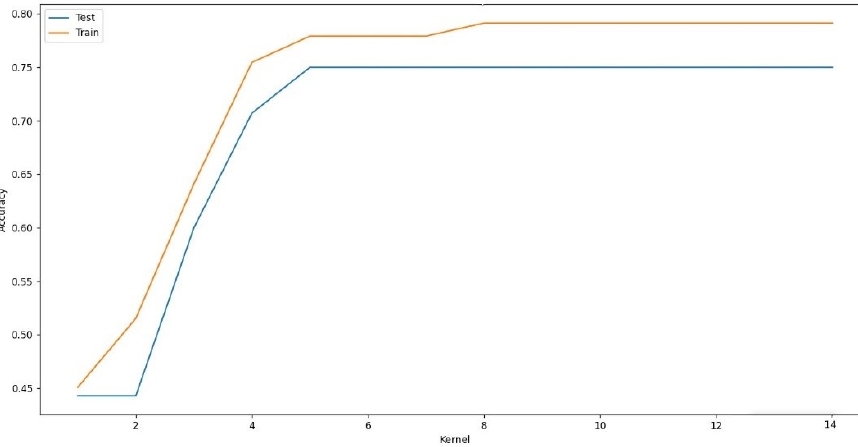
Figure 6. Accuracy of the model in different degrees of polynomial kernel.